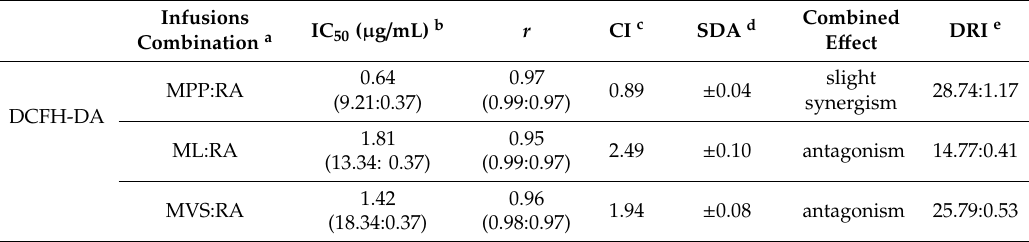
Table 4. Interaction analysis of mutual mint infusions and mint extracts / rosmarinic acid combinations in DCFH-DA assays: IC 50 , CI, and DRI values of equal mass concentration infusions combinations at 50% inhibition dose level. Infusions Combination